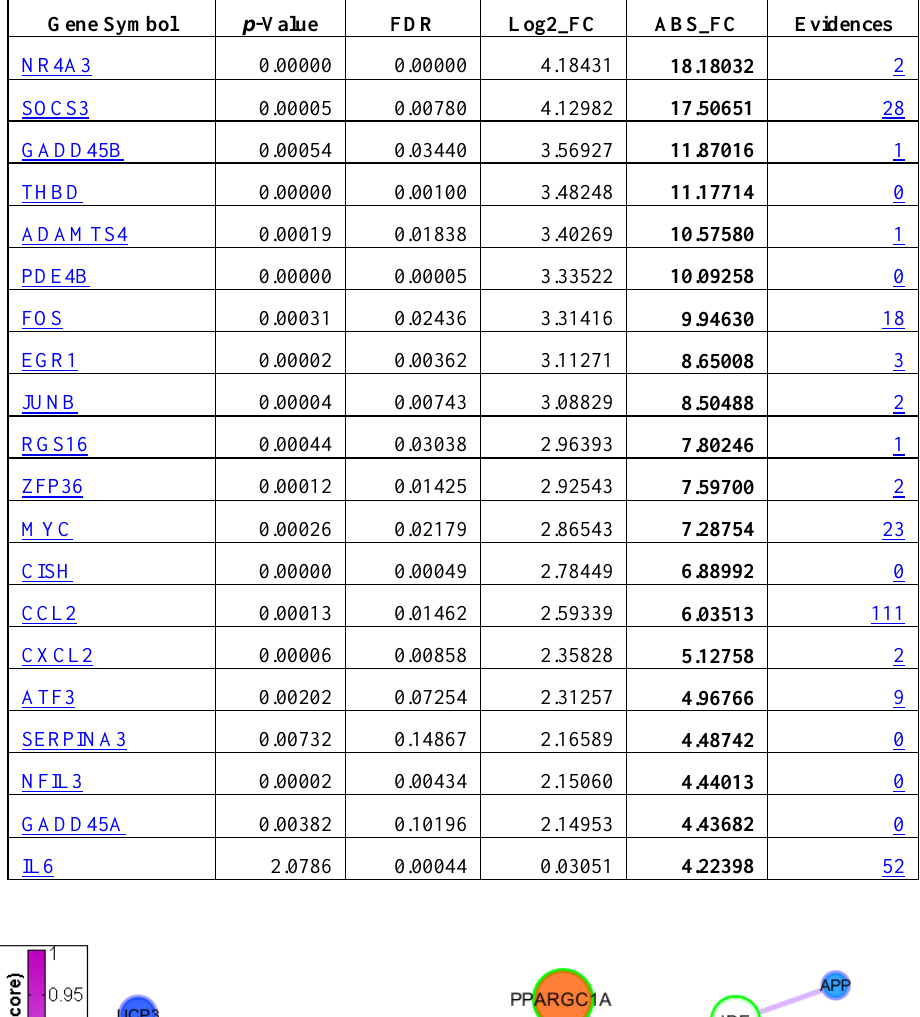
Table 4: Top-20 differential genes in IAB from GSE24215, ordered by FC, (FC>=1.3, p-value <=0.05 and AEL >=40% after applying Limma package in Bioconductor). Note: Gene names are linked to GeneCards.org, UniProt IDs are linked to UniProt.org, and Evidences are linked to PubMed.